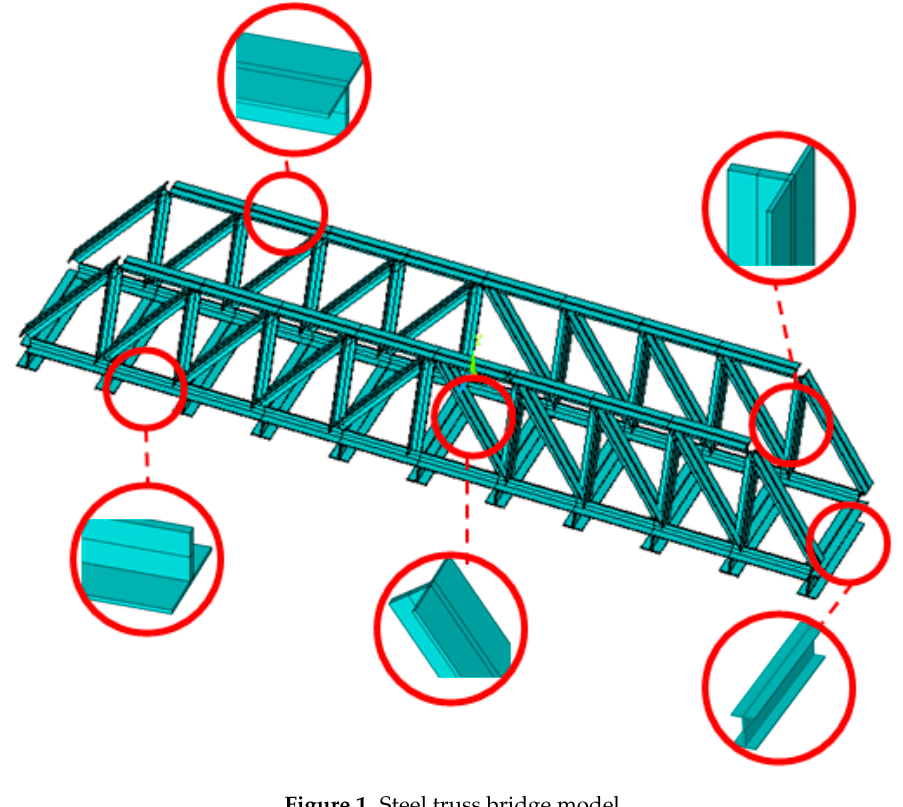
Figure 1. Steel truss bridge model. Table 1. Sectional and material properties of the steel truss bridge